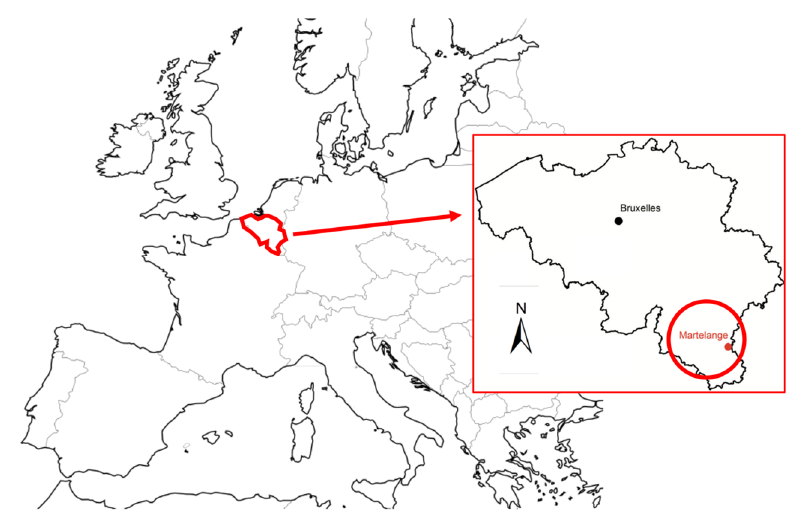
Figure 1. Geographical location of the mine in Martelange that is considered as possible underground reservoir for underground pumped-storage hydropower (UPSH) and is modelled in this study.